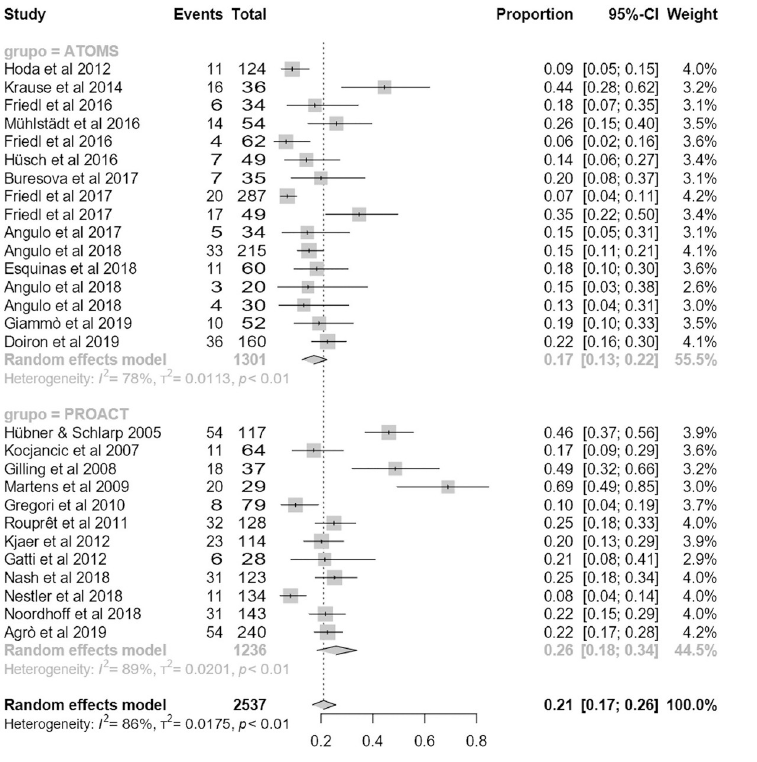
Fig 9. Forest plot of studies analyzed for complication